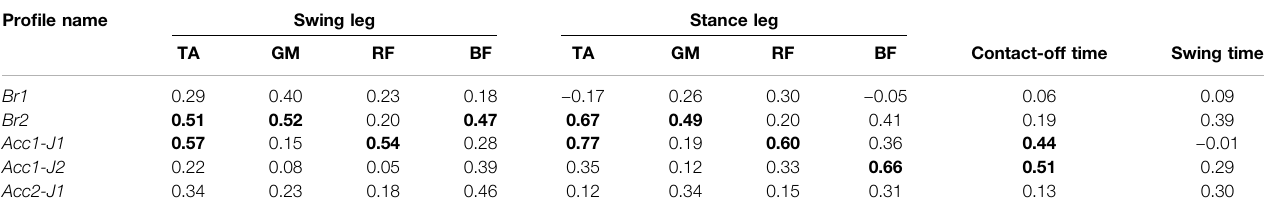
TABLE 9 | Correlations between centre of gravity height and EMG onset latencies, contact-off time and swing time in forward-direction trials. Pro fi le name